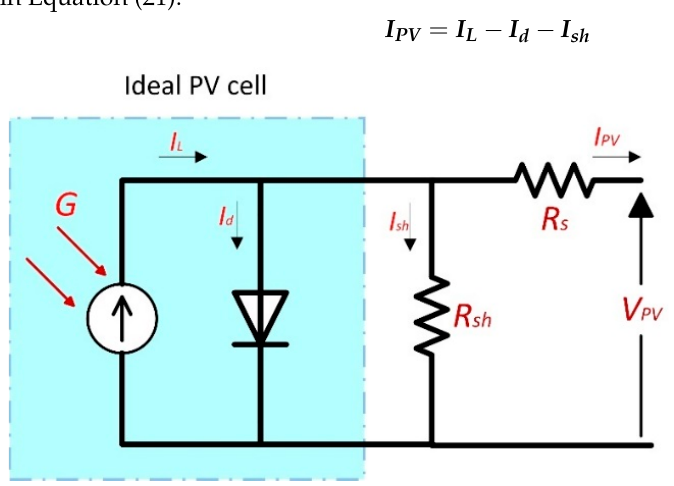
Figure 3. Equivalent circuit of PV